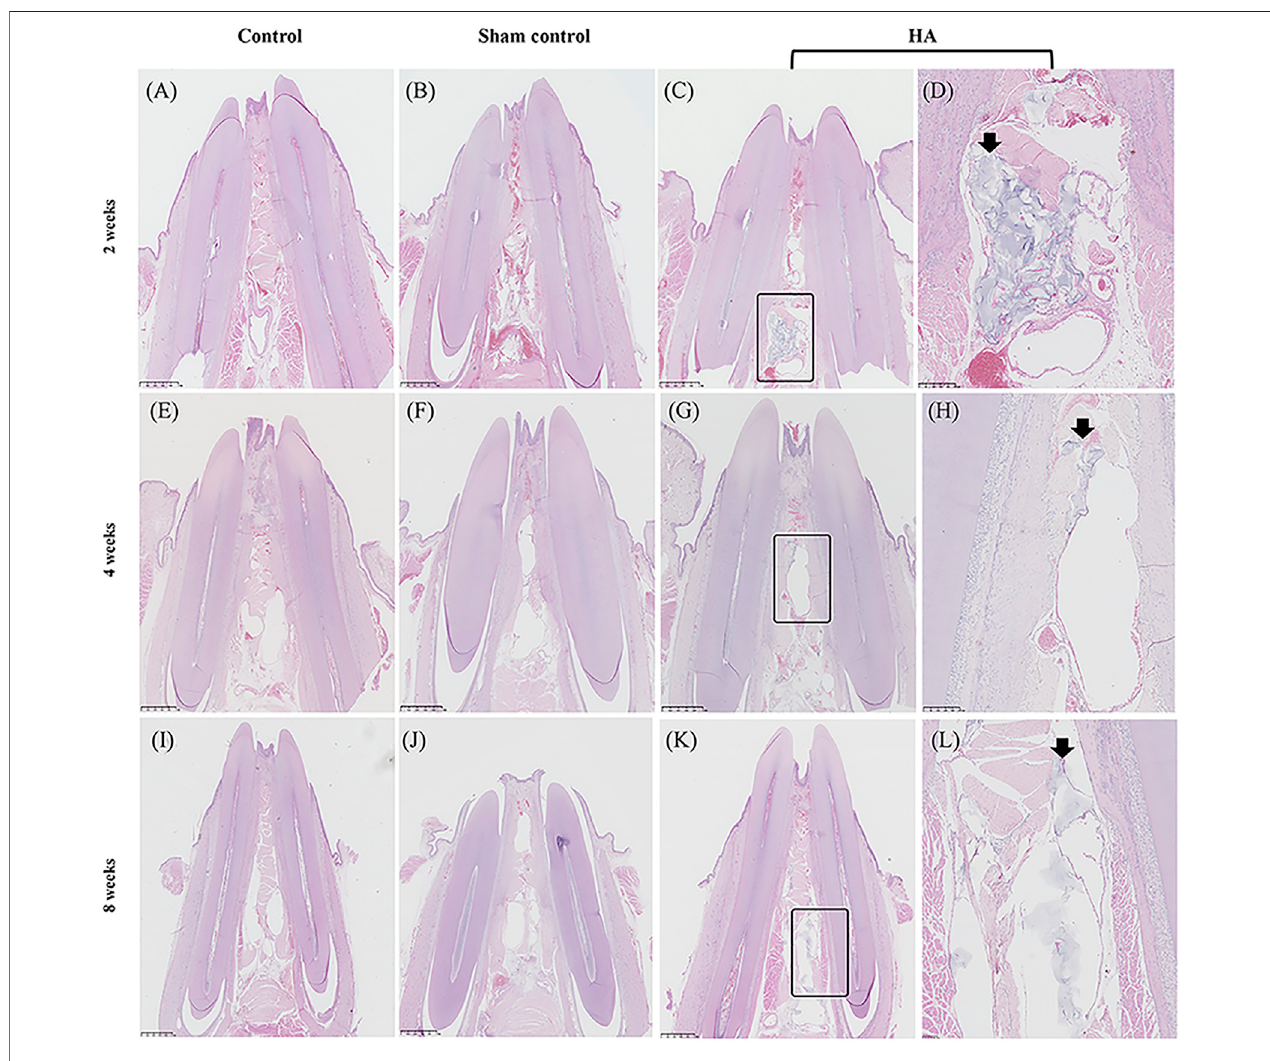
FIGURE 3 | Photo-scanning of HE staining showing the histologic changes in the interdental papilla. Control group at 2 (A) , 4 (E) , and 8 weeks (I) . Sham control groupat2 (B) ,4 (F), and8weeks (J) .HAgroupat 2 (C) ,4 (G) ,and8weeks (K) , n (cid:1) 5.Figure (D) , (H) , (L) arethemagni fi cationoftheblackrectangleareasinFigure (C) , (G) , (K) . The black arrows show the HA fi ller in the interdental papilla surviving from HE staining. Scale bars (cid:1) 1 mm.